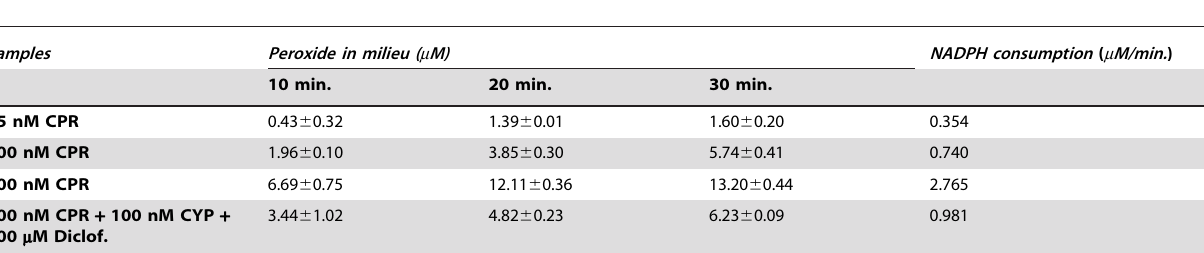
Table 1. Generation of peroxide by CPR from molecular oxygen and NADPH in a pure reconstituted system is presented.